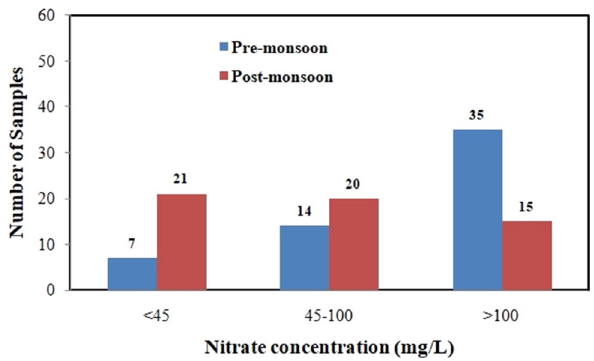
Fig. 6 Nitrate concentration for risk evaluation for drinking water in pre and post-monsoon seasons